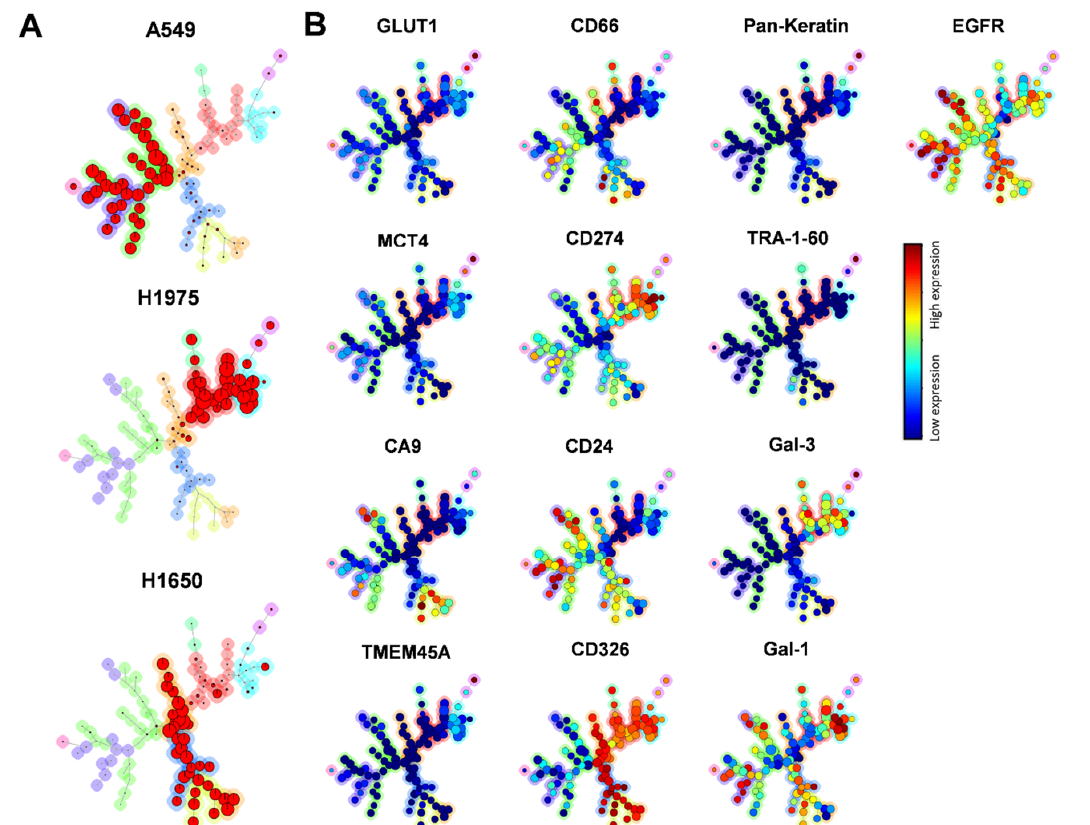
Figure 4. FlowSOM analysis of A549, H1975, and H1650 cells. ( A ) The lineages of tumor cell-line subpopulations were traced and visualized by unsupervised FlowSOM, an algorithm creating MSTs during automated, unsupervised clustering in Cytobank. The A549, H1975, and H1650 cells, based on their different marker-expression profiles, were plotted on different branches (red) of MSTs as cells with inter-cell-line heterogeneity (A549: left branch; H1975: right branch; H1650: lower branch). ( B ) Protein expressions of the three studied cell lines on the aggregated MSTs. Similar cells are assigned to the same node, and the size of node corresponds to the number of events within that cluster; the main subsets are highlighted in the graph. The expression intensities are indicated with coloration varying from blue (low expression) to red (high expression).